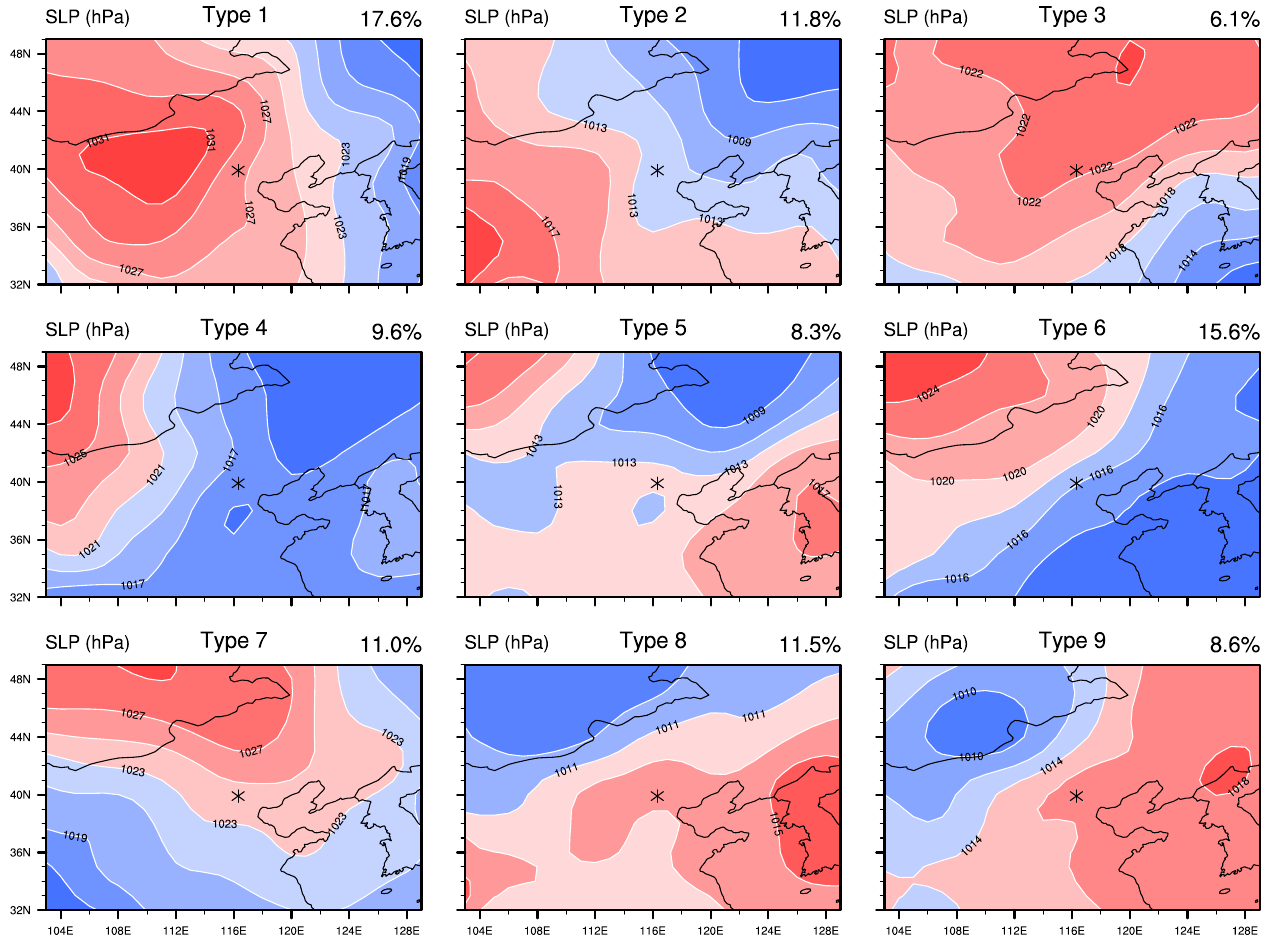
Fig. 2. Mean sea level pressure (SLP) patterns and frequency of occurrence (right upper number) for each circulation type during the period 2000 to 2009. The asterisk represents the location of